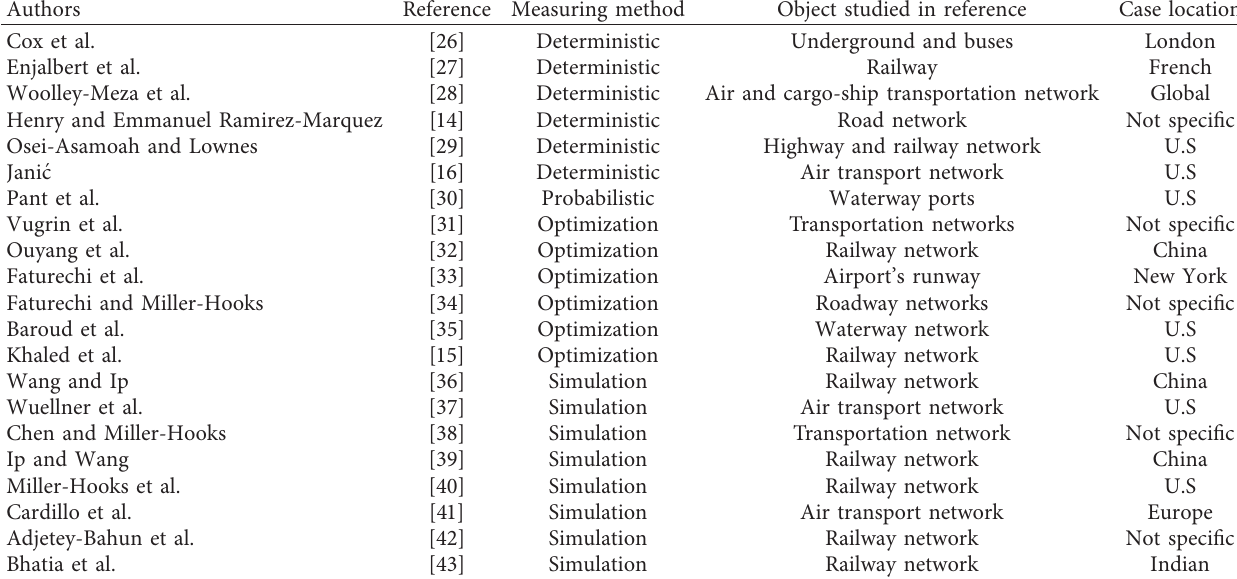
Table 1: Measuring methods for transport infrastructure system